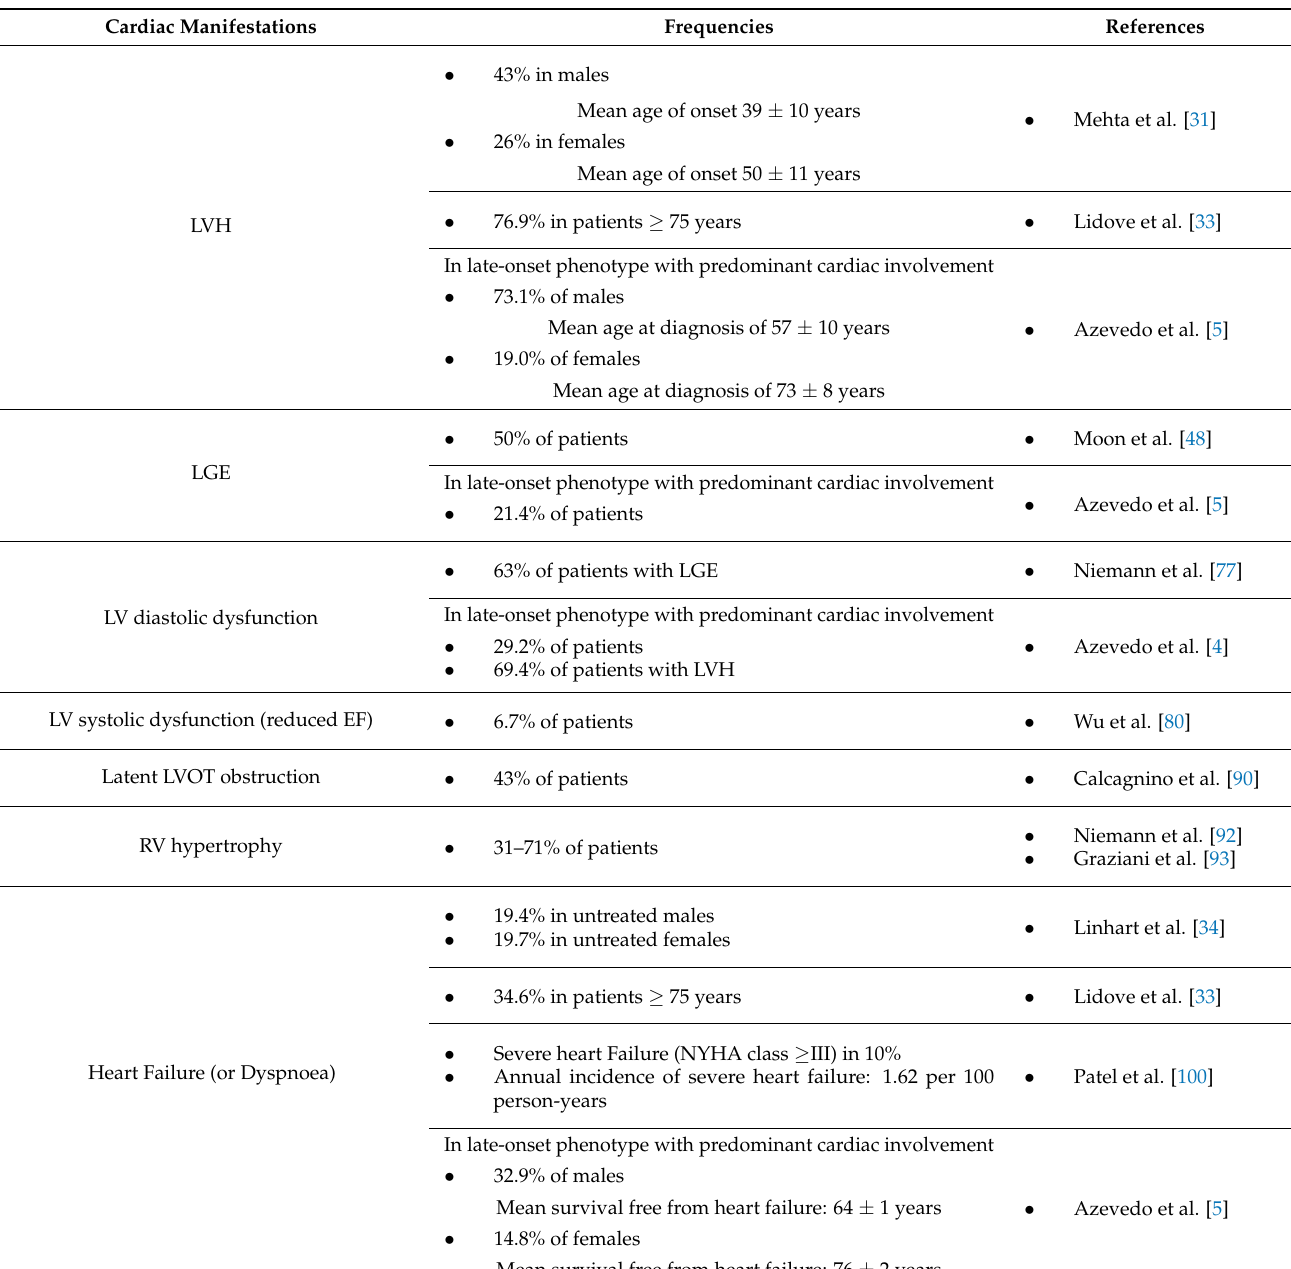
Table 2. Frequency of manifestations related to ventricular hypertrophy, fibrosis and dysfunction in FD. Cardiac Manifestations